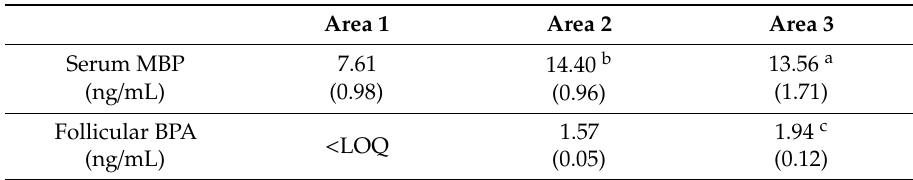
Table 5. BMI adjusted concentration means and standard error (in brackets) of relevant EDCs identified from multi- and uni-variate analyses.